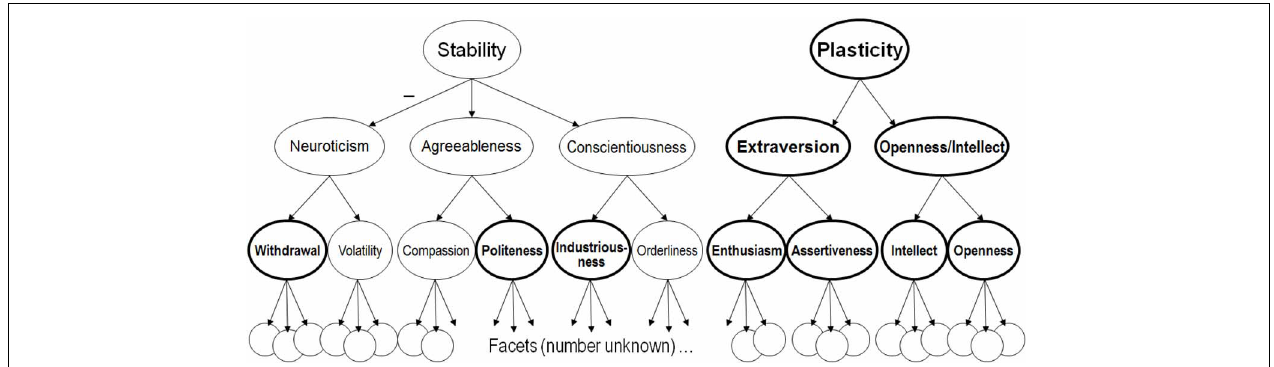
FIGURE 1 | The Big Five personality trait hierarchy (DeYoung, 2006, 2010b; DeYoung et al., 2007). Traits outlined in bold are hypothesized to be influenced by dopamine.